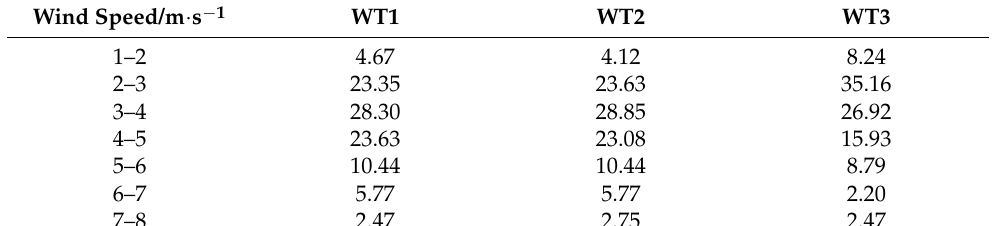
Table 1. Frequency distribution of the mean daily wind speed at the height of 3.0 m from the three wind-towers (%).